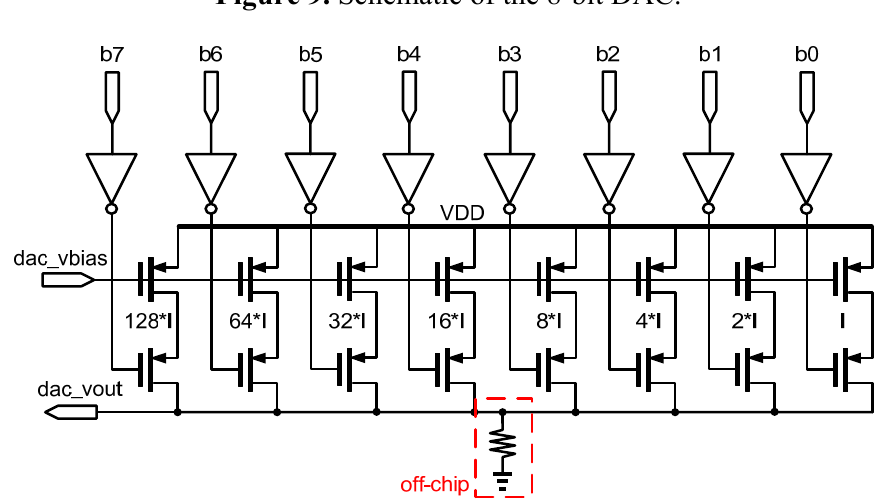
Figure 9. Schematic of the 8-bit DAC.